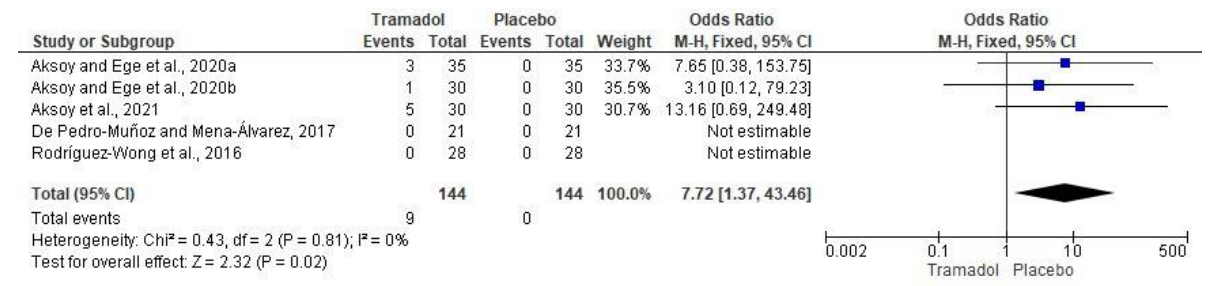
Figure 3. Forest plot of the effect of local tramadol versus placebo/local anesthetics on anesthetic success.